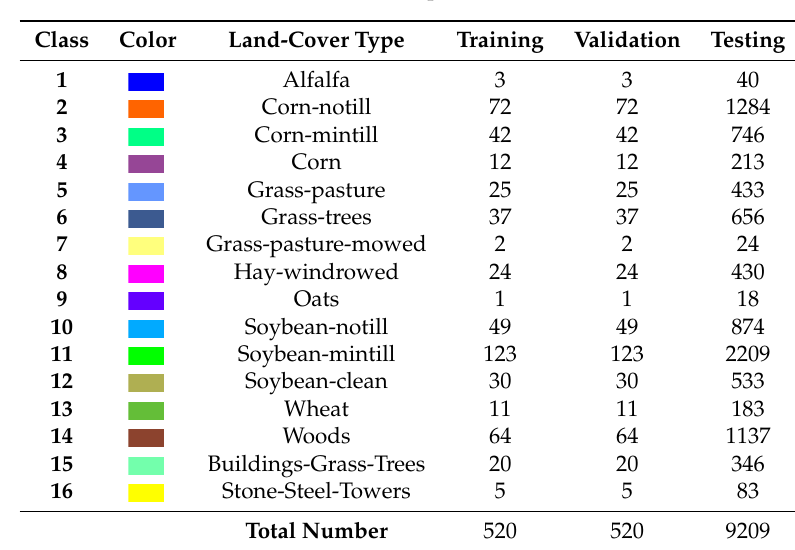
Table 3. Number of samples of the IP dataset.